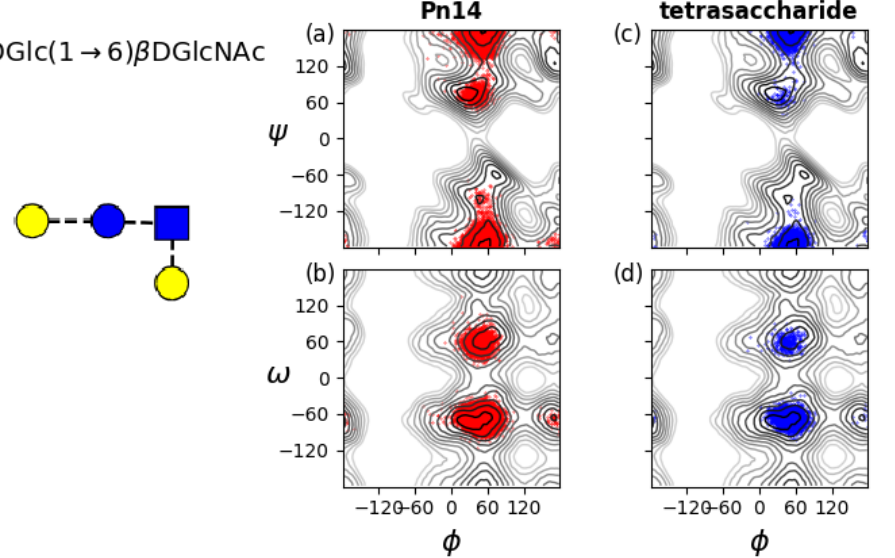
Figure A2. Rotation of the three-bond β D Glc(1 → 6) β D GlcNAc linkages in Pn14 and the effective tetrasaccharide epitope previously identified (left) [14]. Time series scatter plots are superimposed on the φ , ψ PMF (top row) and the φ , ω PMF (bottom row) for the two central β D Glc(1 → 6) β D GlcNAc linkages for: ( a ) Pn14 φ , ψ ; ( b ) Pn14 φ , ω ; ( c ) tetrasaccharide φ , ψ ; and ( d ) tetrasaccharide φ , ω